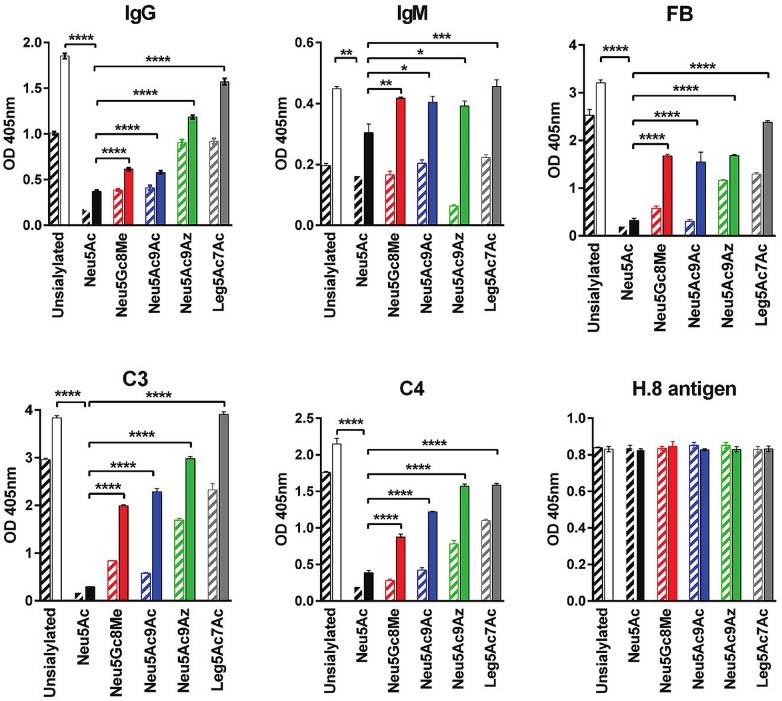
IgG, IgM, and complement components C3, C4 and FB deposition on N. gonorrhoeae (Ng) F62 that have incorporated each indicated sialic acid analog into lipooligosaccharide (LOS).
Ng F62 ΔlgtD was grown in media alone (open bars), or media supplemented with 20 μg/ml (~30 μM) of each of the indicated CMP-Sias (NulOs). Bacteria were incubated with either 3.3% or 10% normal human serum (NHS) at 37°C for 10 min and IgG and IgM binding, and C3, C4 and factor B (FB) deposited on bacteria were measured by whole cell ELISA. Data with 3.3% and 10% NHS is shown using hatched and solid bars, respectively. mAb 2-8C-4-1 [62] that detects the Neisserial lipoprotein H.8 was similar across all groups and confirmed similar capture of bacteria in all wells (bottom right graph). Measurement of gonococcal H.8 lipoprotein antigen was performed to assess similarity of bacterial capture across microtiter wells. The mean (SD) of three observations is shown. Significance of differences in Ig or complement component binding/deposition using each analog vs, Neu5Ac is indicated for results that used 10% NHS only (for simplicity): *, P<0.05; **, P<0.01; ***, P<0.001; ****, P<0.0001 (ANOVA). Controls with bacteria alone yielded OD405nm readings <0.1 (negative).